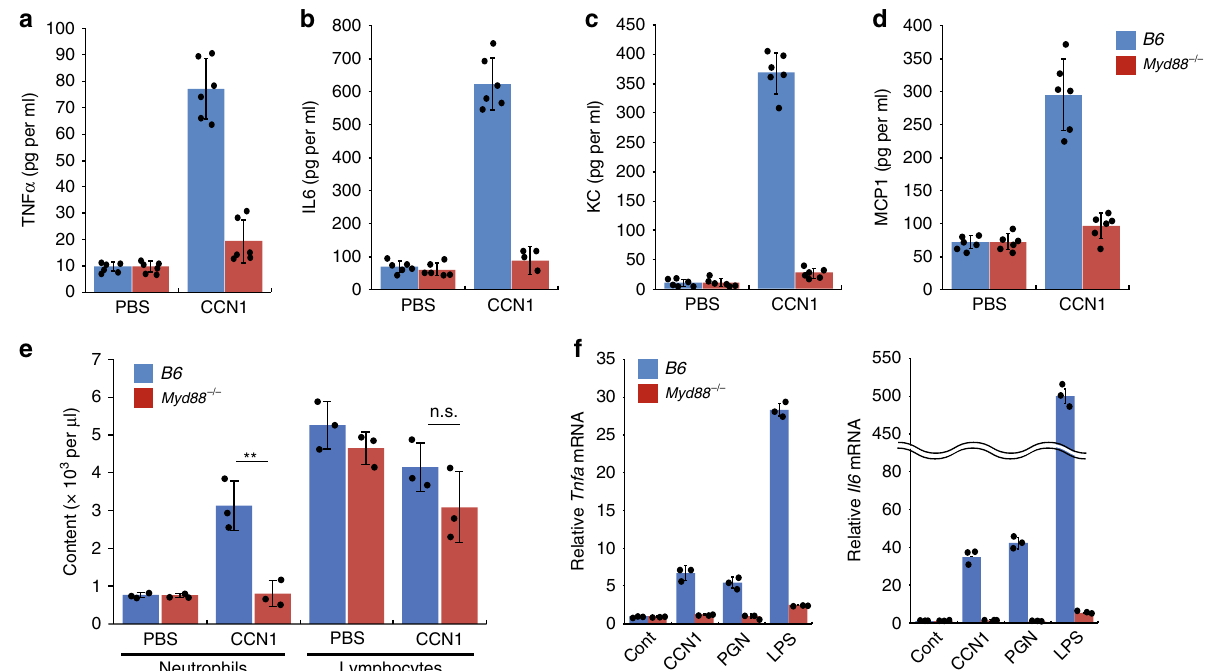
Fig. 7 CCN1 induces Myd88 -dependent in fl ammatory response. a – d C57BL/6J ( B6 ) and Myd88 − / − mice ( n = 6 each genotype) were i.p . injected with CCN1 protein (5 µ g in 300 µ l PBS), and peritoneal exudates were analyzed for TNF α (30 min) and IL6, KC, and MCP1 (2 h) using ELISA. e Complete blood count (CBC) analysis was performed, and neutrophils and lymphocytes contents are shown. f Gene expression induced by CCN1. BMDMs from B6 or Myd88 − / − mice were treated with CCN1 protein (2 µ g per ml), LPS (50 ng per ml), or PGN (5 µ g per ml) for 6 h. Tnfa and Il6 mRNAs were quanti fi ed by qRT-PCR analyses. All data are represented as mean ± s.d. acquired in triplicate determinations. Statistical evaluation was performed by one-sided,